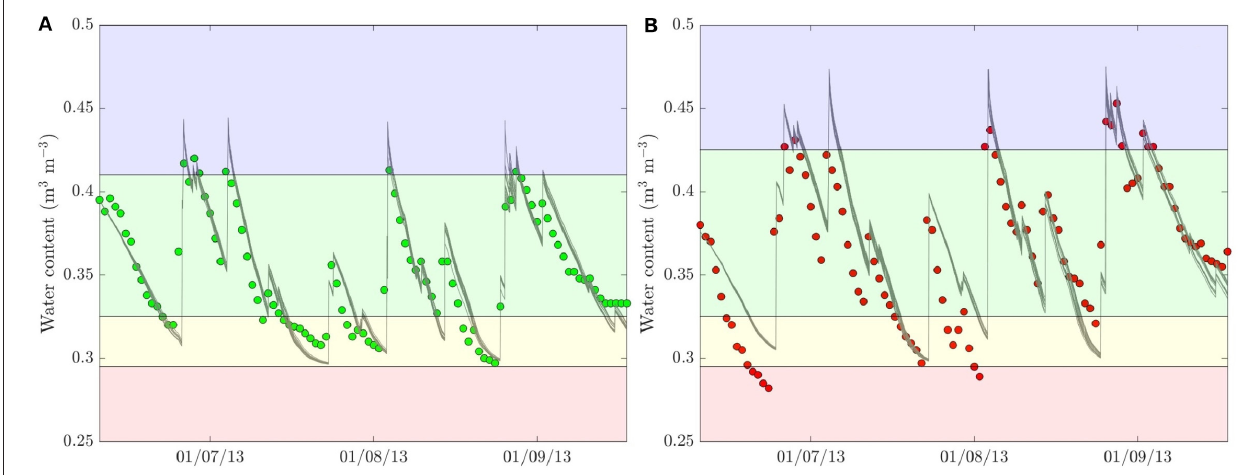
FIGURE 3 | Measured (circles) and simulated (solid lines) daily water content in (A) the informed site and (B) the uninformed site. The simulation results refer to the final 10 sets of parameters derived with DREAM. The blue, green, yellow, and red regions indicate soil moisture ranges where percolation, optimal ET, partially stressed ET, and no ET occur, respectively. The soil moisture thresholds delimiting the four regions are field capacity, stress point, and wilting points, respectively.